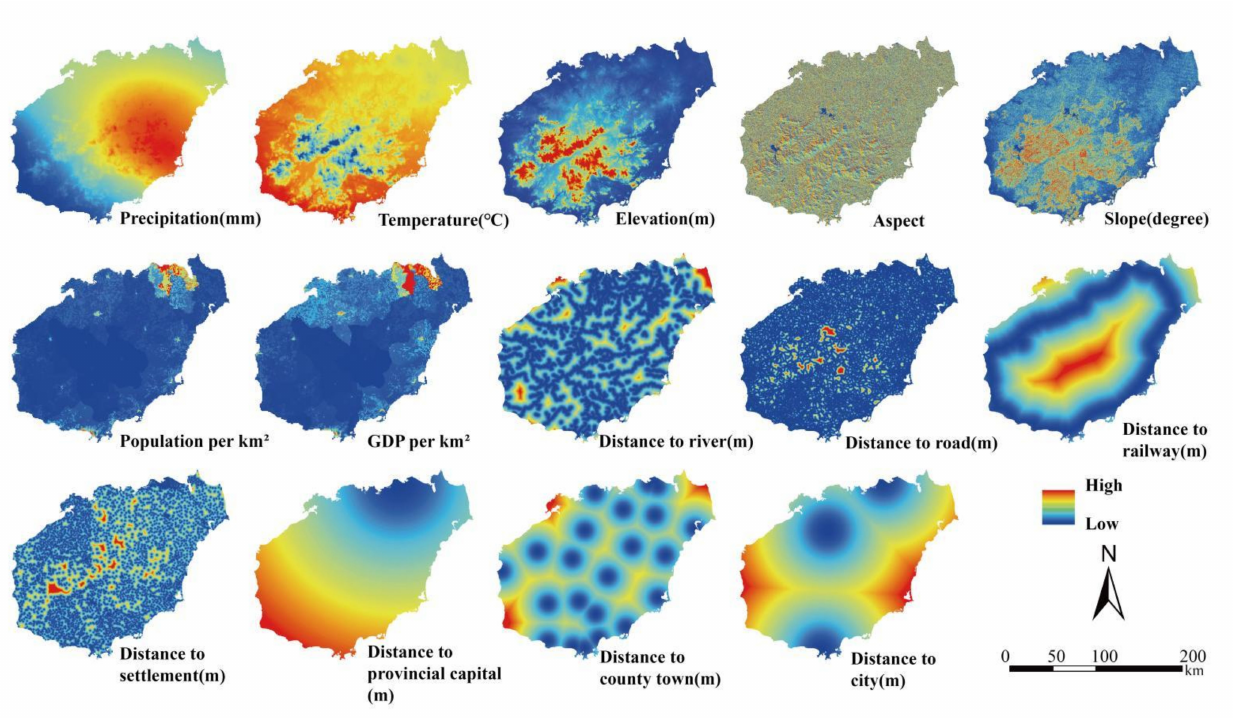
Figure 2. Driving factors of LULC